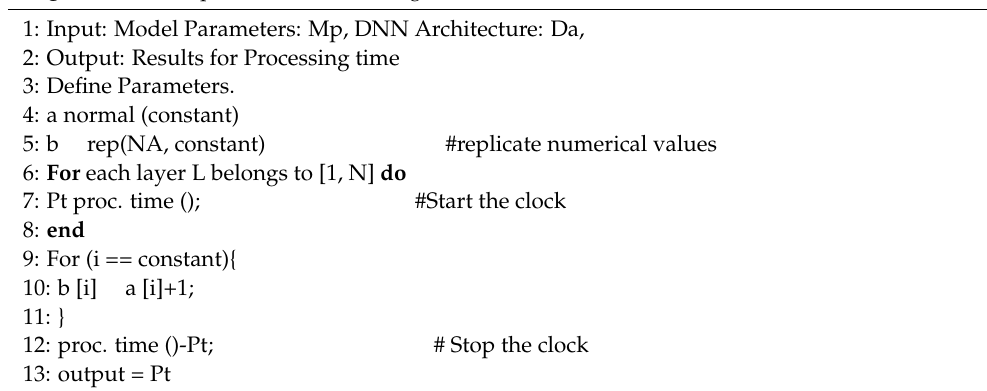
Algorithm 2 Computation of Processing